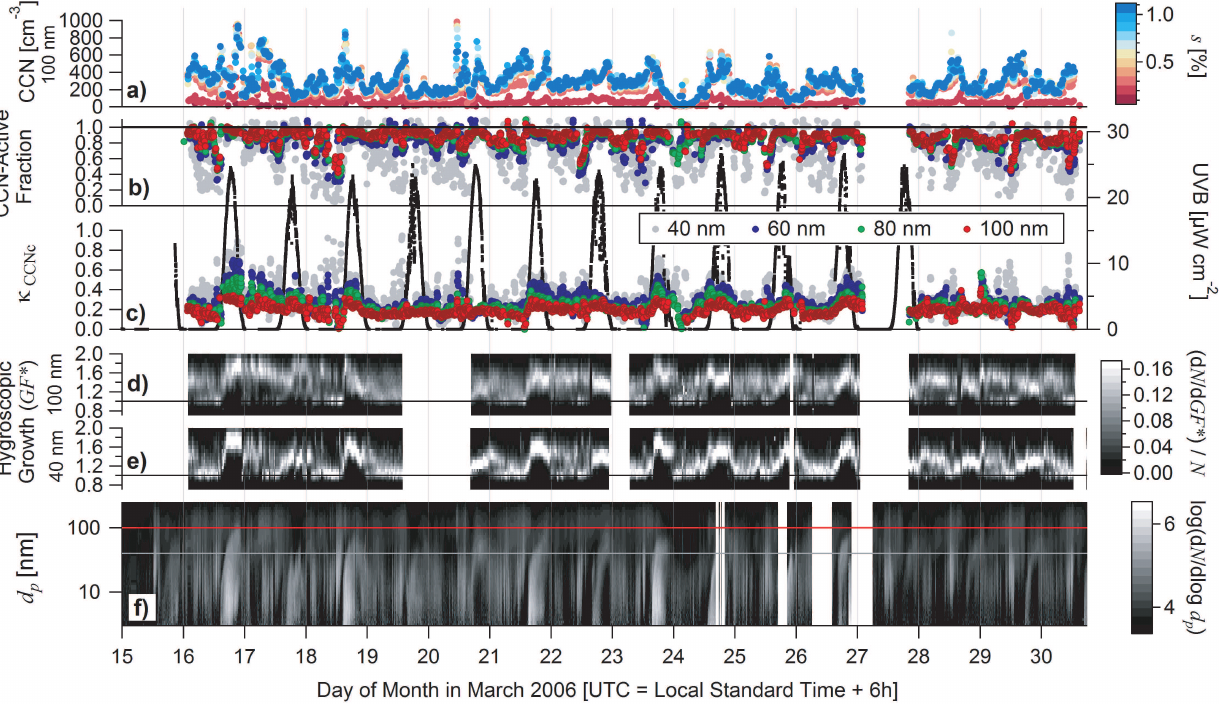
Fig. 2. Overview time series of measured aerosol microphysical properties during the MIRAGE 2006 campaign: (a) number concentration of 100nm particles acting as CCN, (b) fraction of particles acting as CCN at ∼ 1% supersaturation, (c) hygroscopicity parameter for the CCN-active fraction, hygroscopic diameter growth factor distribution for (d) 100nm and (e) 40nm particles, and (f) aerosol size distribution for 3–250nm particles, with 40nm and 100nm highlighted in grey and red, respectively. In (b) and (c) , parameters are reported for 40, 60, 80 and 100nm selected dry particle diameters. The growth factor distributions in (d) and (e) are normalized to particle number concentrations.